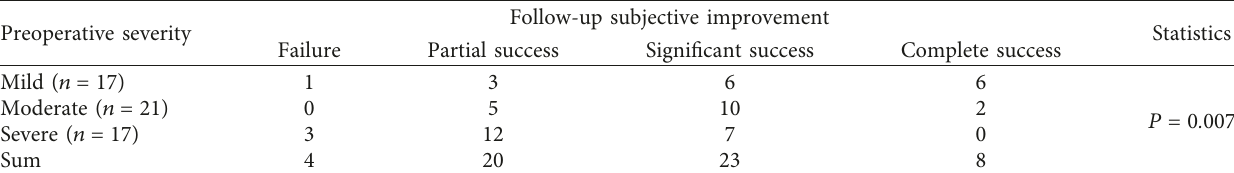
Figure 1: NEI VFQ-25 scores before YAG and at 6-month follow-up. (a) Changes of VFQ-25 scores before YAG and at 6-month follow-up. (b) Follow-up VFQ-25 scores in eyes with different preoperative severity. Table 2: Follow-up self-reported improvement by